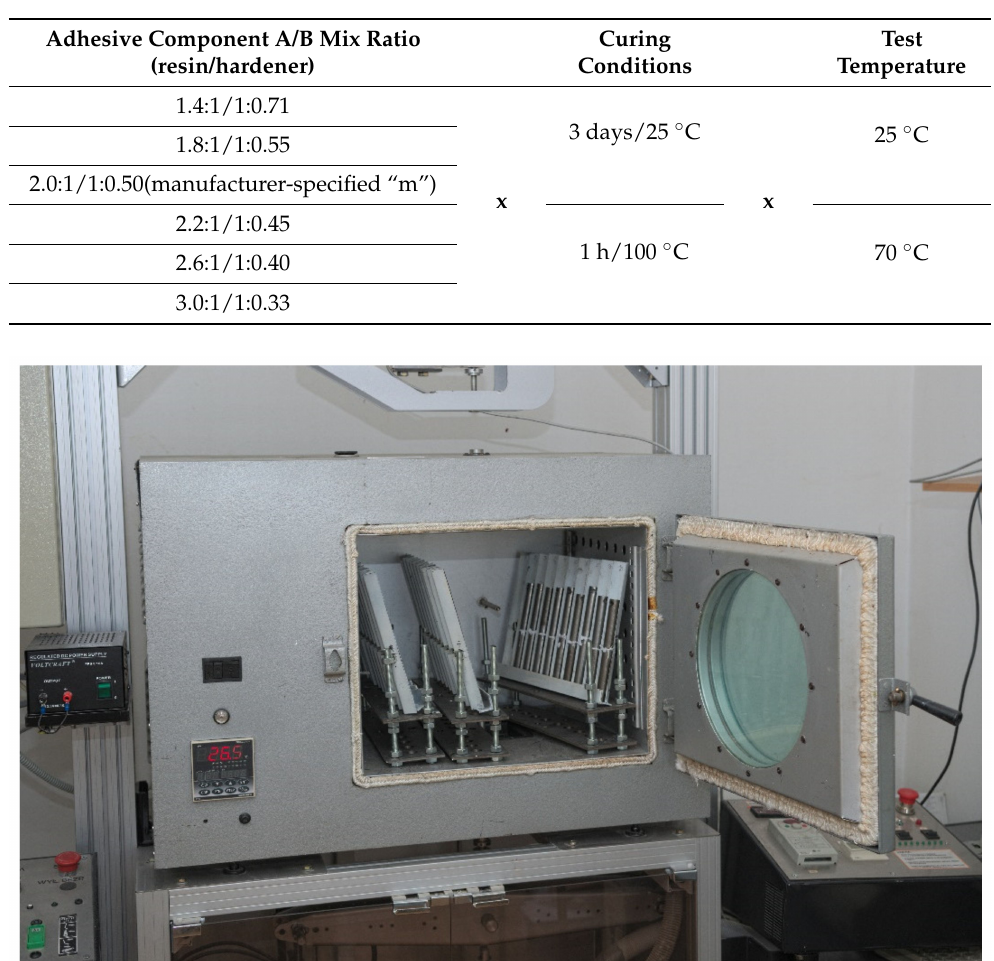
Figure 3. Self-alignment fixture in heating